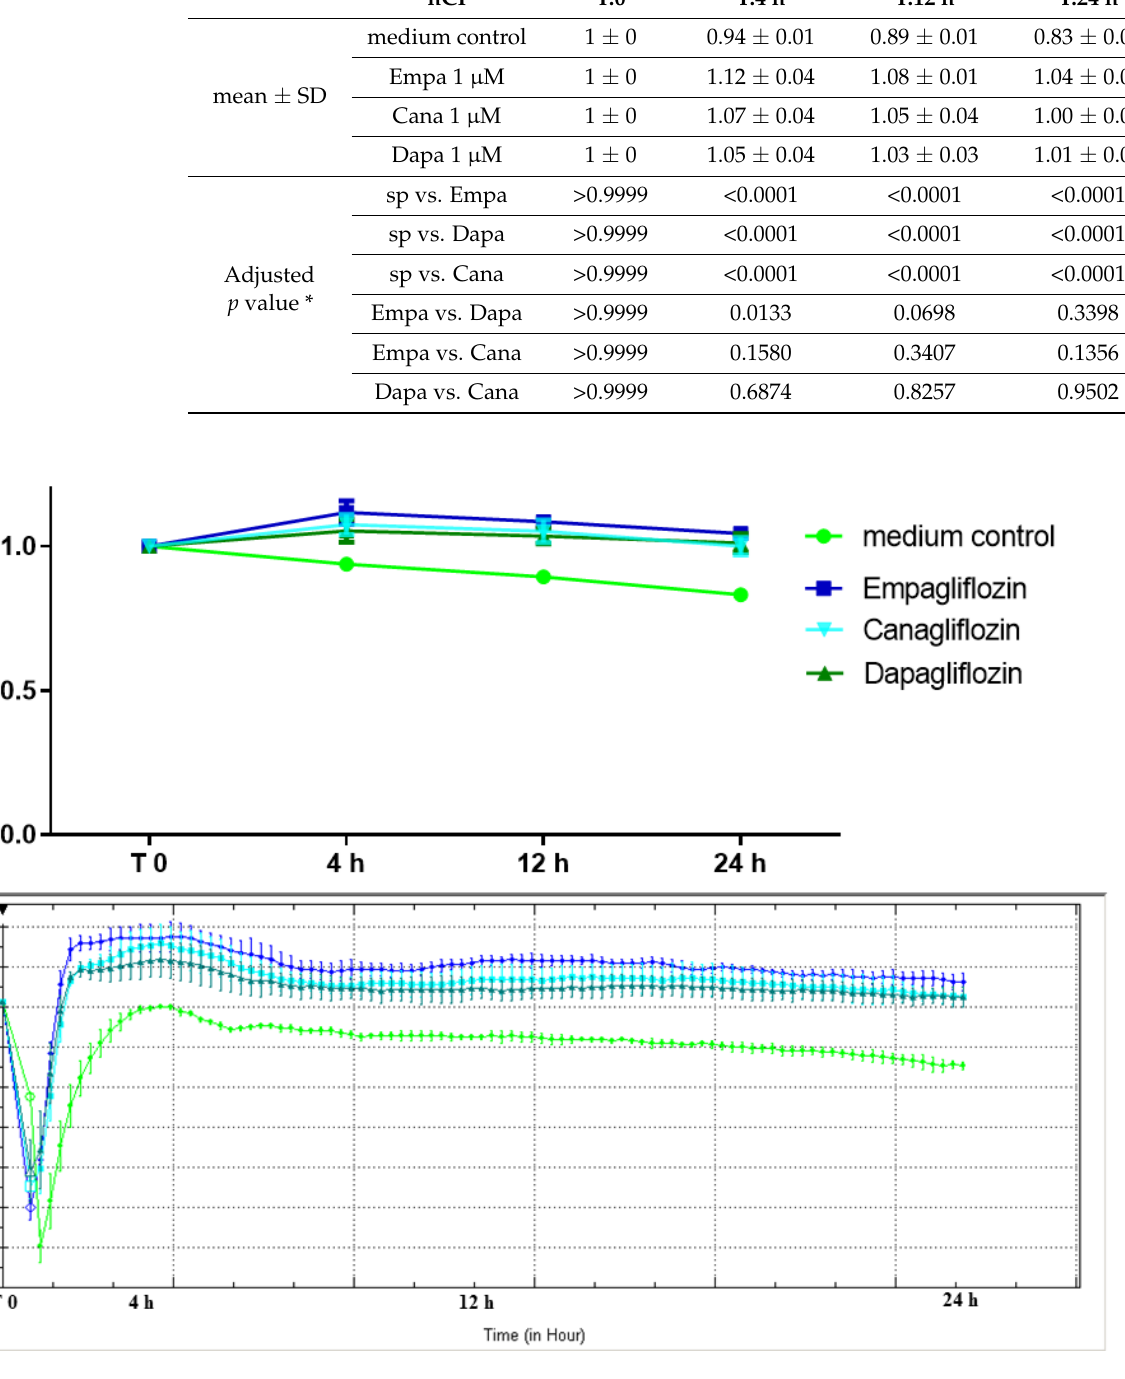
Figure 1. ( A ) The effect of SGLT2 inhibitors empagliflozin (1 µM), canagliflozin (1 µM), and dapagliflozin (1 µM) on the integrity of HUVECs. Data were collected by real-time cell electric impedance sensing system. ( B ) Representative plot from the real-time cell electric impedance sensing system, each line represents the mean of three wells of each condition.